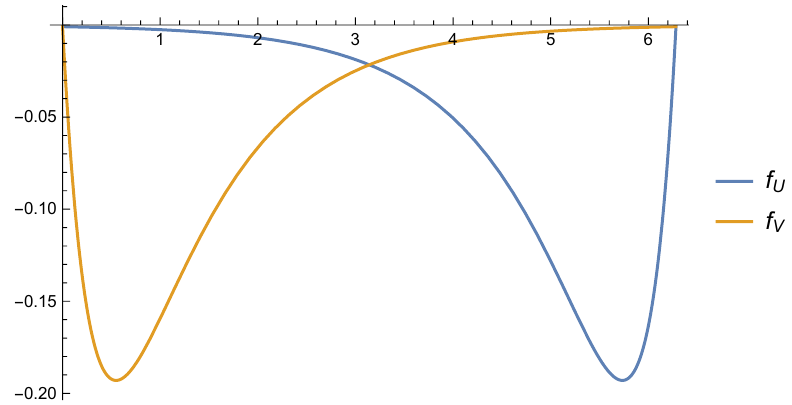
Figure 11 . Pro(cid:12)les for the U and V shocks for r + = 2, r (cid:0) = 1. The asymmetry between the two results from enhancement due to the rotation direction. The overall scale of either pro(cid:12)le could be changed by including a scaling factor in the appropriate stress